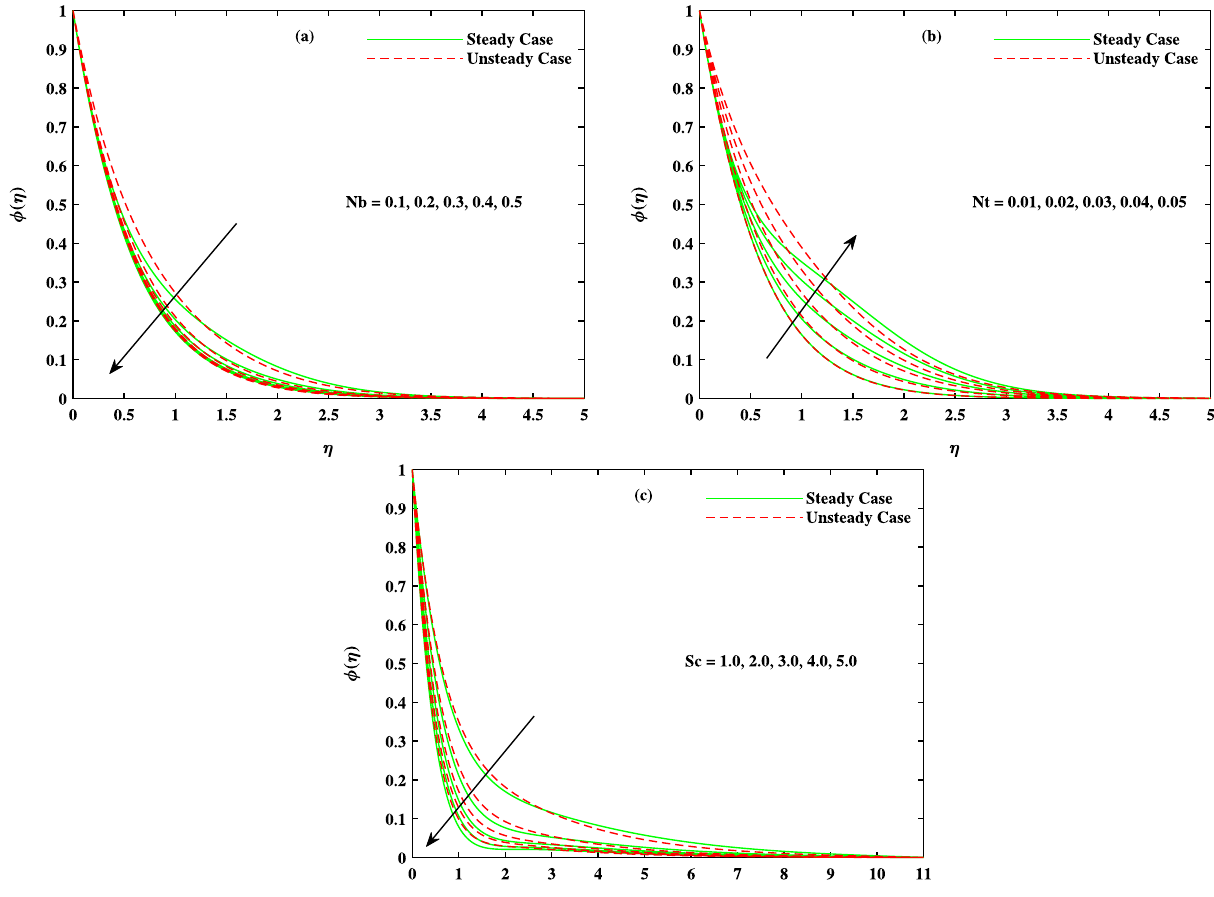
Figure 6. Fluctuation in concentration φ(η) with ( a ) Nb , ( b ) Nt and ( c ) Sc